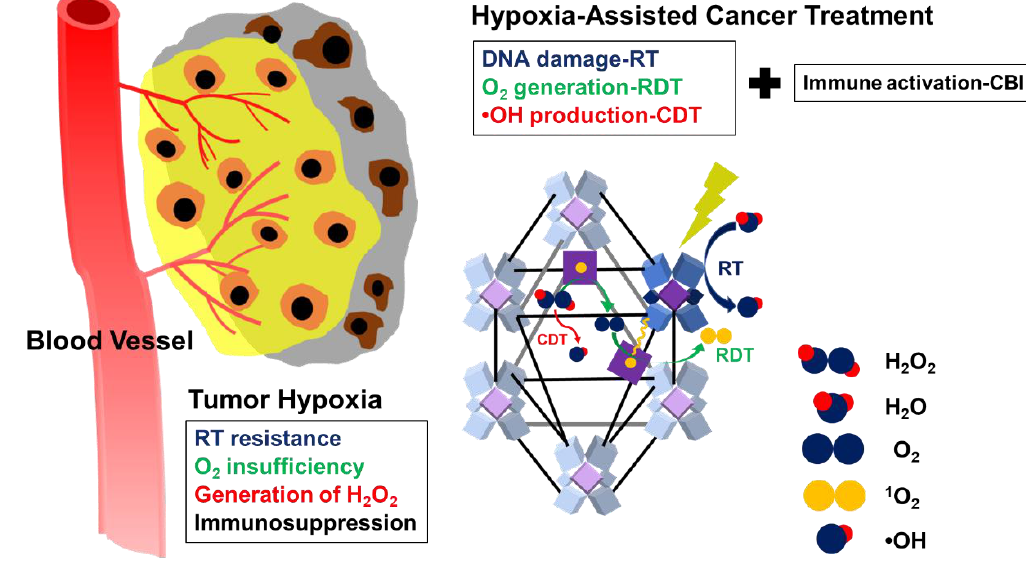
Figure 6. Schematic illustration of the mechanism of the nMOF as a multifunction platform for combining CDT, radiotherapy (RT), RDT, and immunotherapy for treating hypoxic tumors. Reproduced from [118]. Published by The Royal Society of Chemistry.